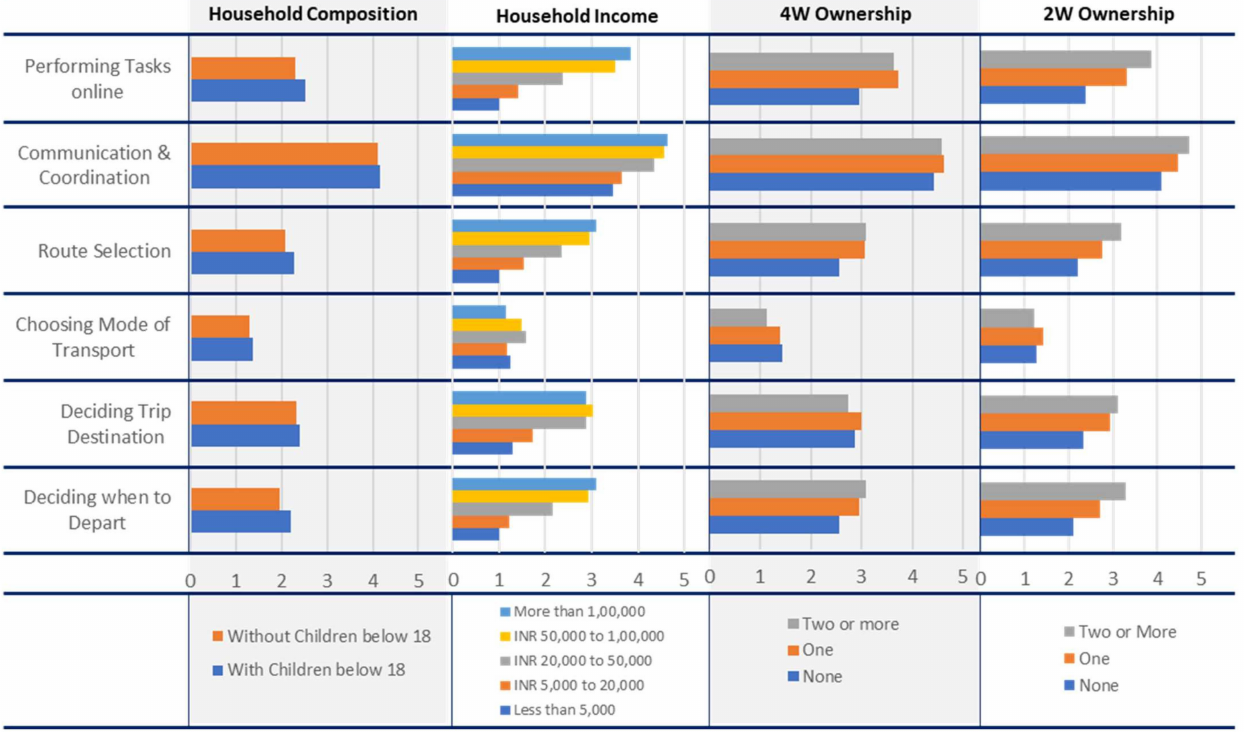
Figure 2. Household-level mean scores for trip planning